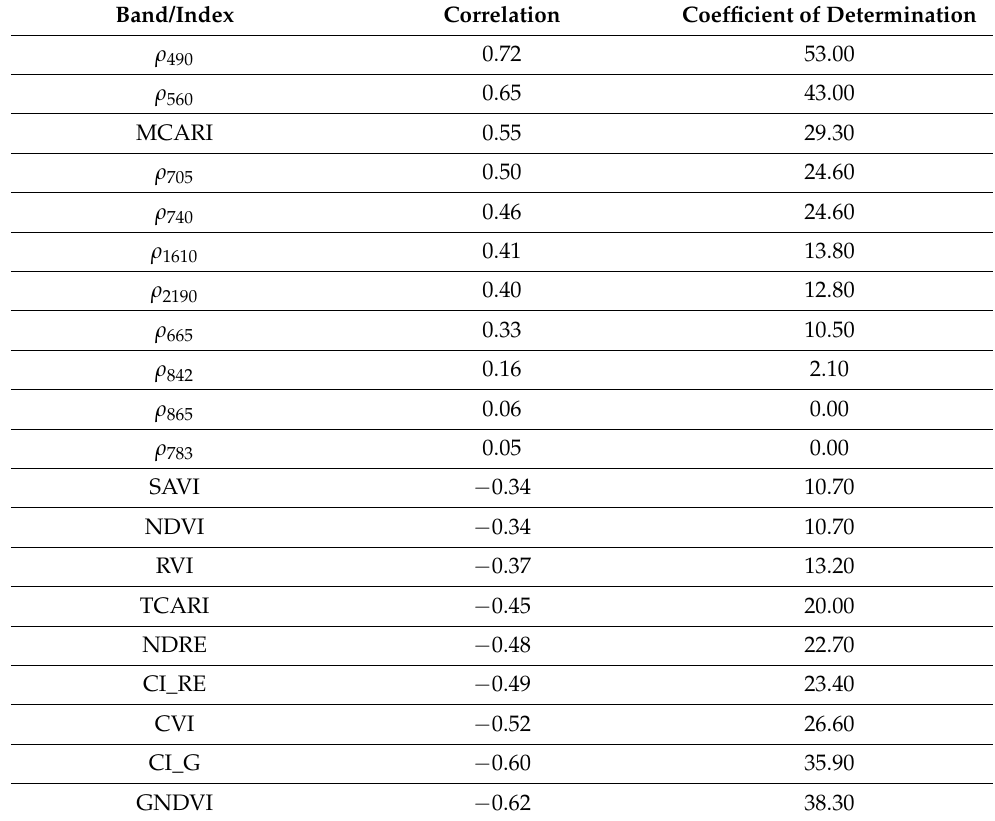
Table 4. Correlation between the vegetation bands/indices and